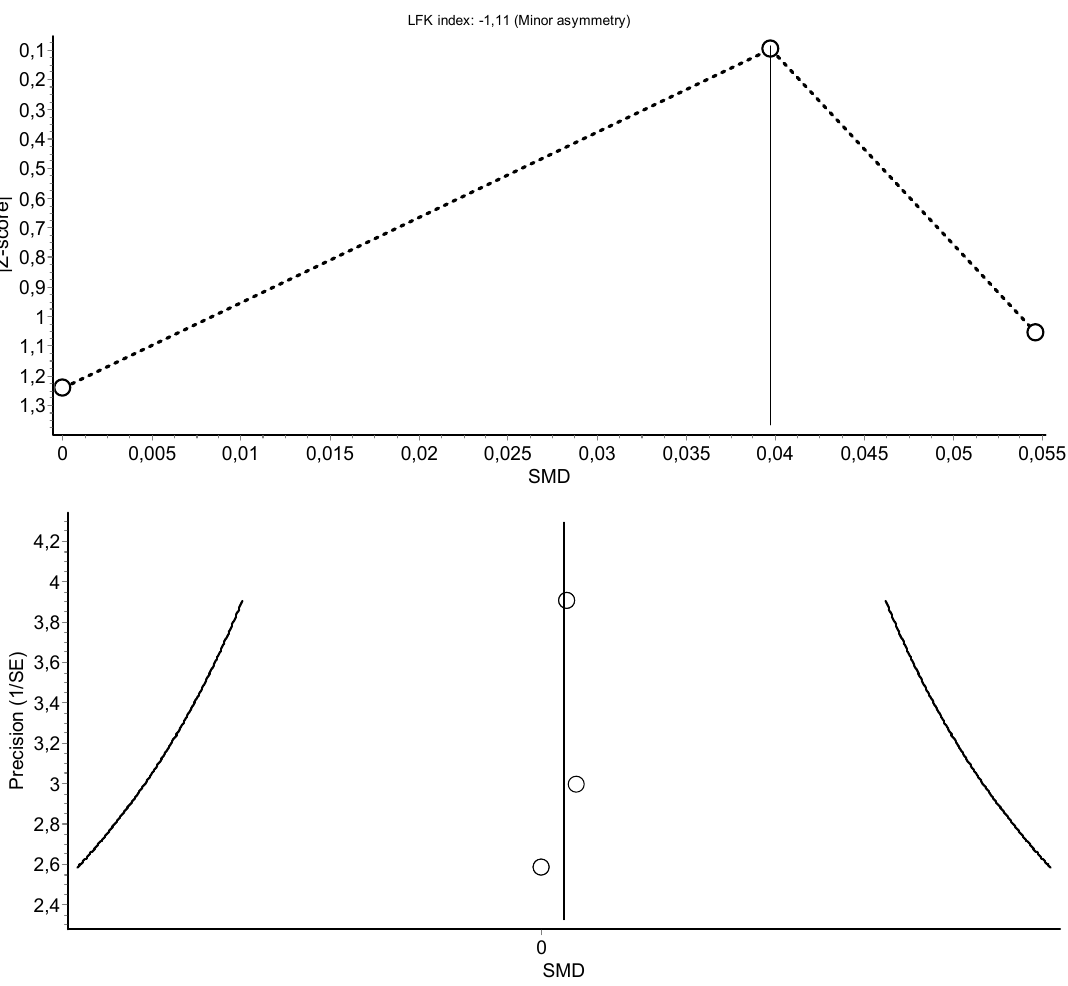
Figure A12. Synthesis funnel and Doi plot (LFK index) for C-reactive protein.